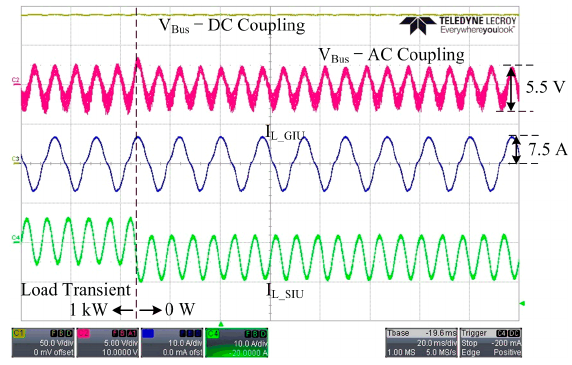
Figure 12. Experimental waveforms of the step ‐ load changing condition.